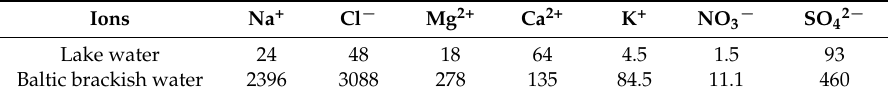
Table 2. The concentration of major ions in the feeding water [mg/L].